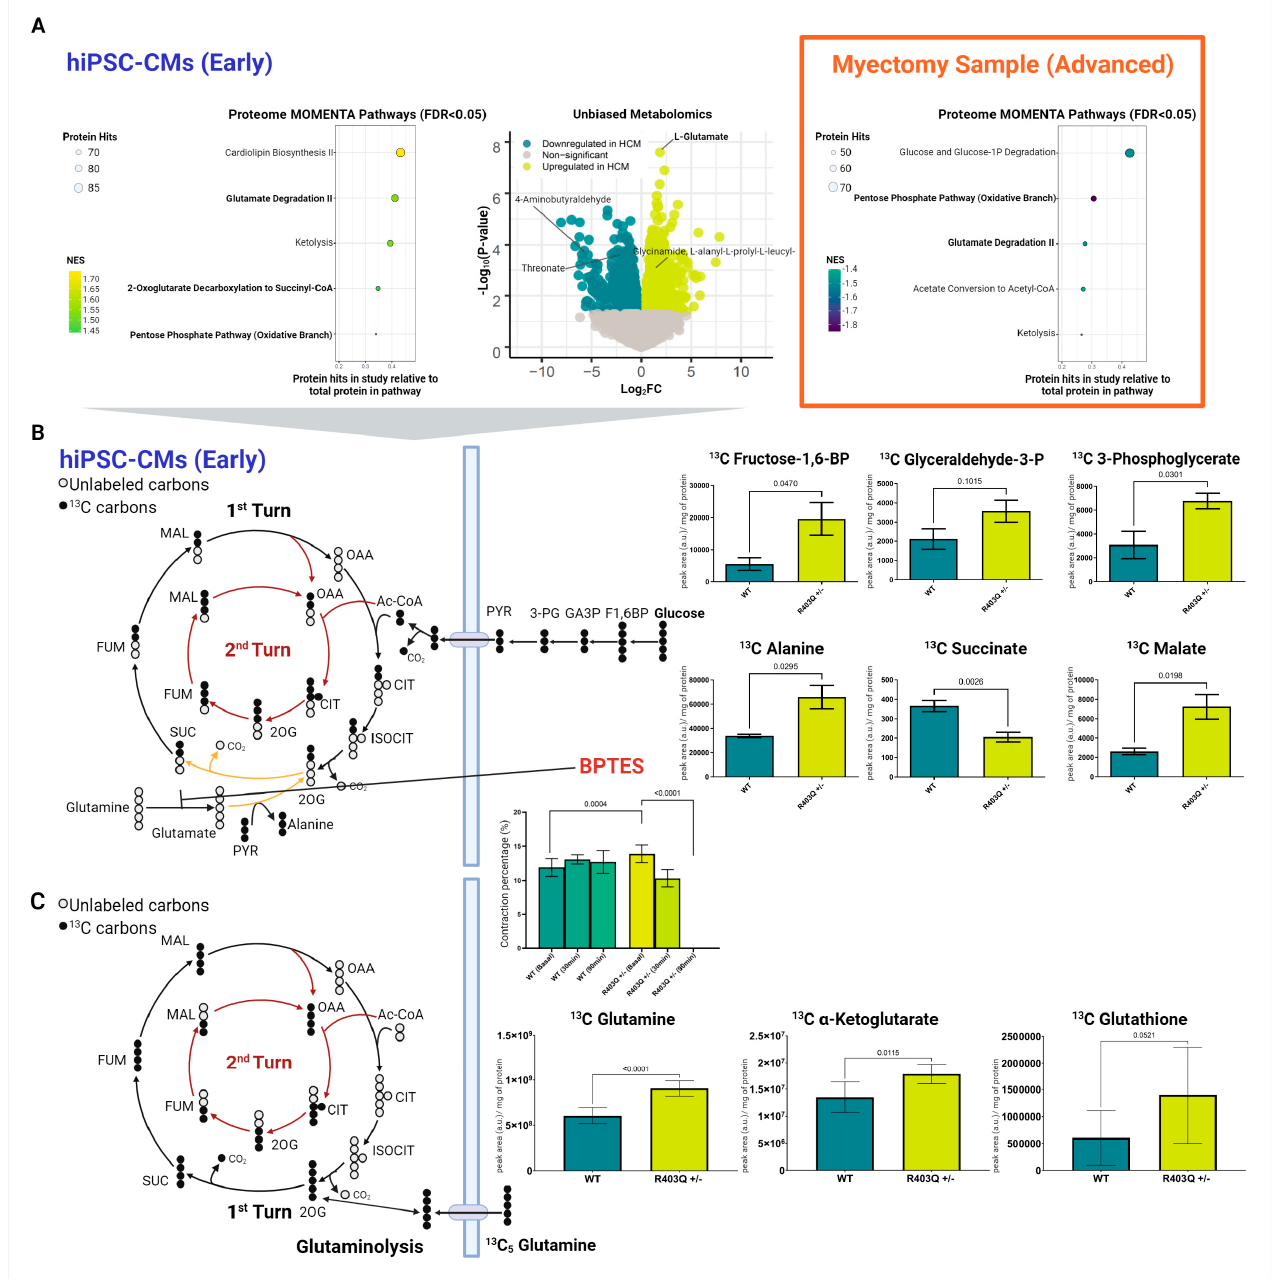
Figure 4. Integrated metabolomic analysis of patient myectomies and hiPSC-CMs. ( A ) Top differential pathways enriched in mutant versus control samples based on metabolic enrichment network analysis of the hiPSC-CM proteomic datasets (left), volcano plot of differential metabolite features from global (positive ion mode) metabolomic analysis of CM metabolites (middle), and enriched biochemical pathways revealed by metabolic enrichment network analysis of the patient myectomy samples (right). ( B ) Targeted mass-spectrometry-based metabolomics of hiPSC-CMs using isotopically heavy labeled 13 C glucose, including after treatment with BPTES over a 90 min period. ( C ) Targeted mass-spectrometry-based metabolomics using isotopically labeled 13 C glutamine. Individual data plots across all experiments are shown with means ± SD ( N = 8). F1,6BP = fructose 1,6-bisphosphate, GA3P = glyceraldehyde 3-phosphate, 3-PG = 3-phosphoglycerate, PYR = pyruvate, Ac-CoA = acetyl-CoA, CIT = citrate, ISOCIT = isocitrate, 2OG = 2-oxoglutarate, SUC = succinate, FUM = fumarate, MAL = malate, OAA = oxaloacetate.